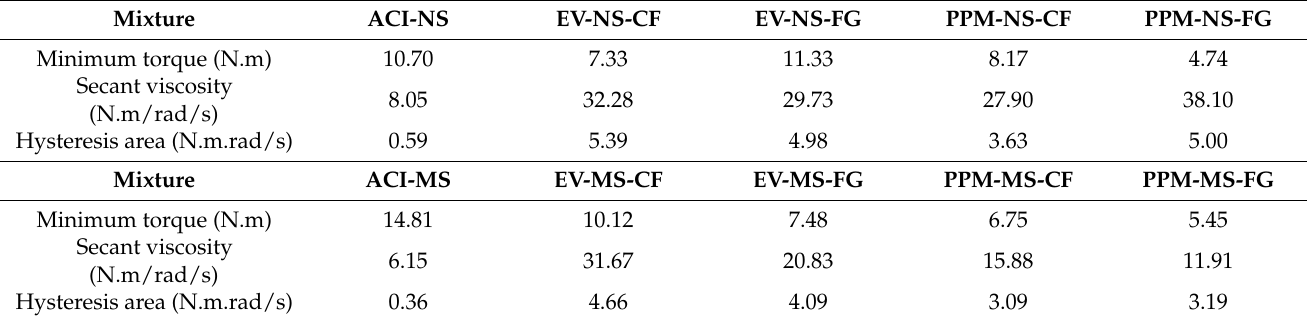
Table 5. Fresh-state properties of concrete mixtures appraised.